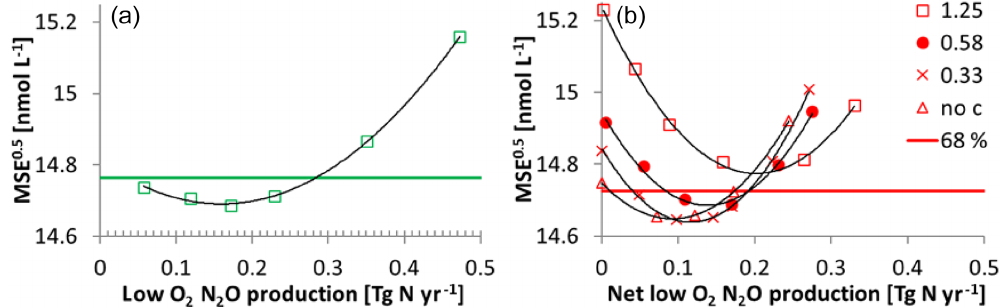
Figure 9. MSE 0 . 5 for the two N 2 O submodels compared to the N 2 O concentration database as a function N 2 O production in the low-O 2 regions. MSE min was obtained as the minimum of a second-order polynomial fit (black lines). The 1 σ confidence interval, where MSE equals the value calculated from Eq. (5), is indicated by the horizontal lines. (a) Diagnostic submodel; each point represents a simulation with a different low O 2 ratio. (b) Prognostic model; “no c” is with no N 2 O consumption, i.e. net production = gross production. All other lines have a constant gross production (see legend for a description of the symbols, TgNyr − 1 ), and net production varies with different N 2 O consumption rates. Range of parameter values is given in Supplement Sect. 8.7.